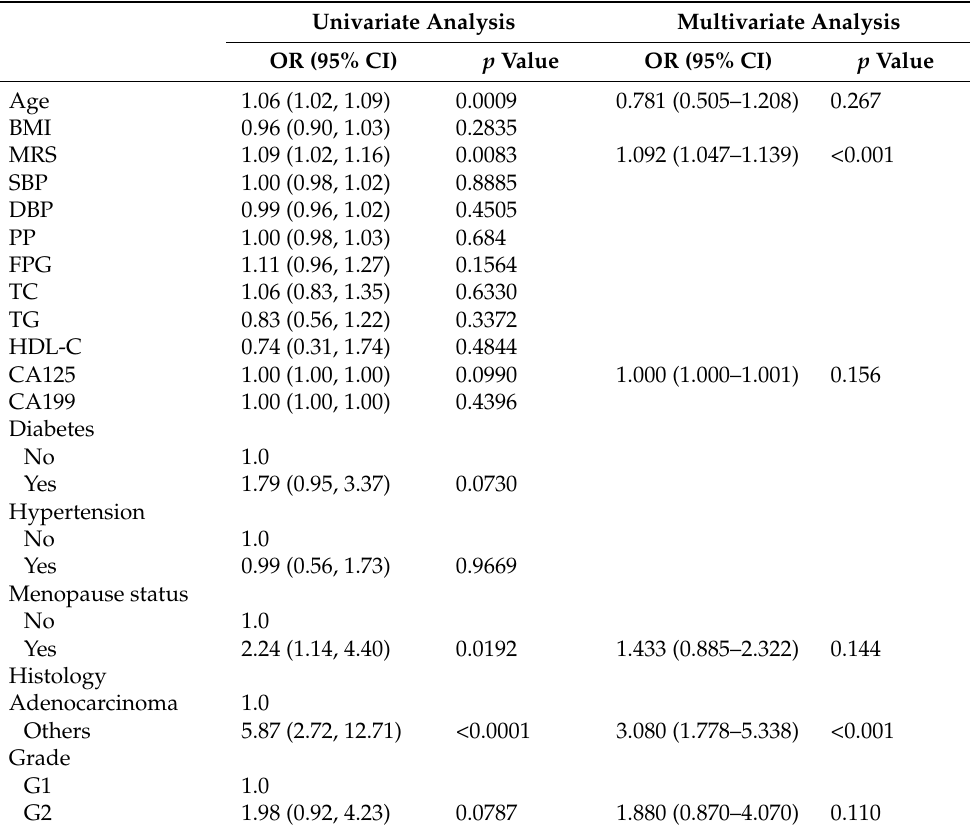
Table 4. Univariate and multivariate analysis of LVSI in the validation cohort. Univariate